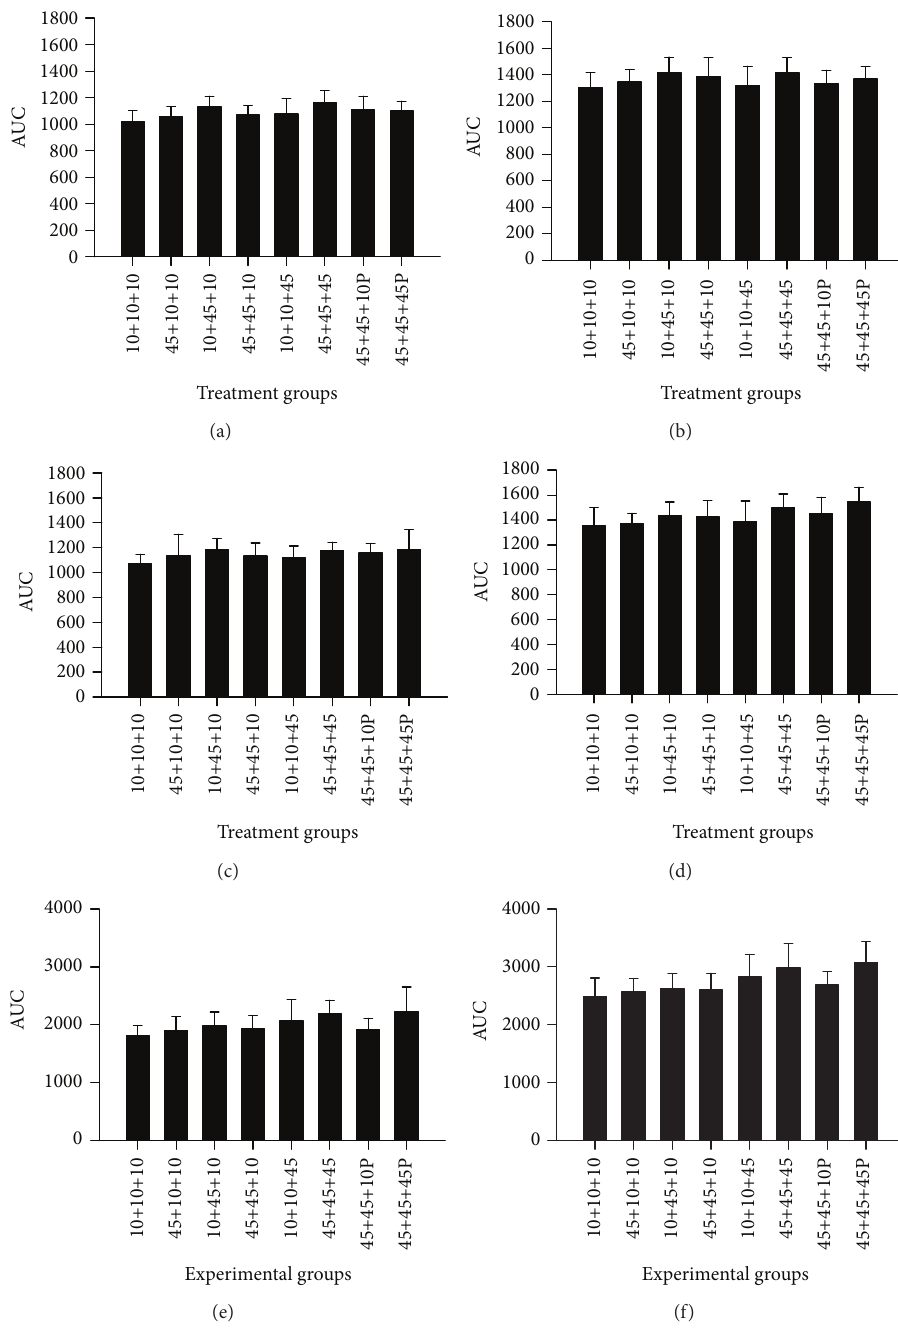
Figure 6: Body weight development as AUC (arbitrary units, mean ± SD) from age 3-4 days to 11 weeks for (a) Min/+ females, (b) Min/+ males, (c) wild-type females and (d) wild-type males, and from age 12 to 23 weeks for (e) wild-type females and (f) wild-type males. The experimental groups are as explained in the legend to Figure 1. 𝑛 = 20 – 46